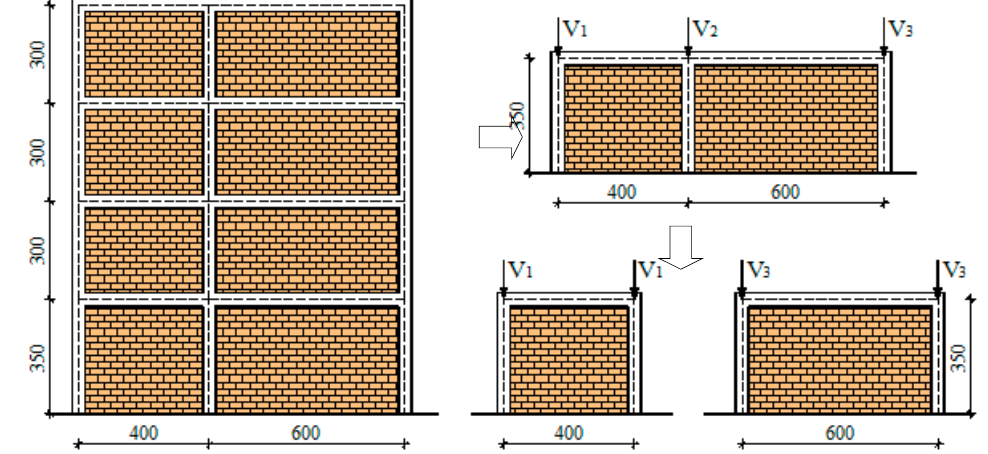
Figure 13. Approximation model for multi-storey multi-bay infilled frame Patras.